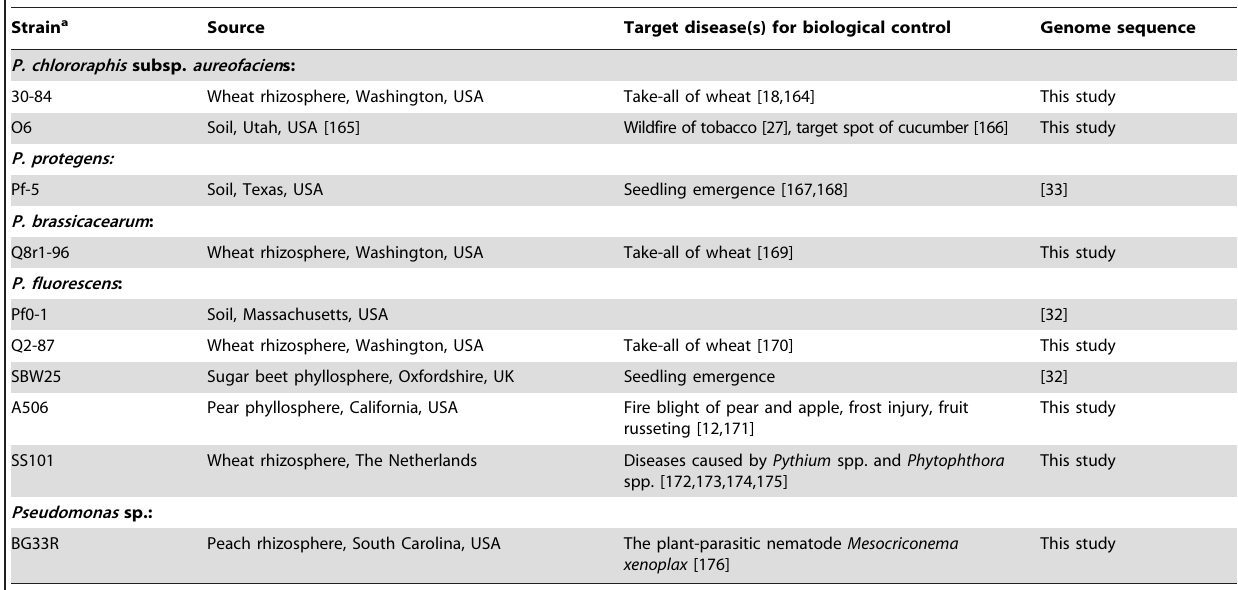
Table 1. Strains of the Pseudomonas fluorescens group.